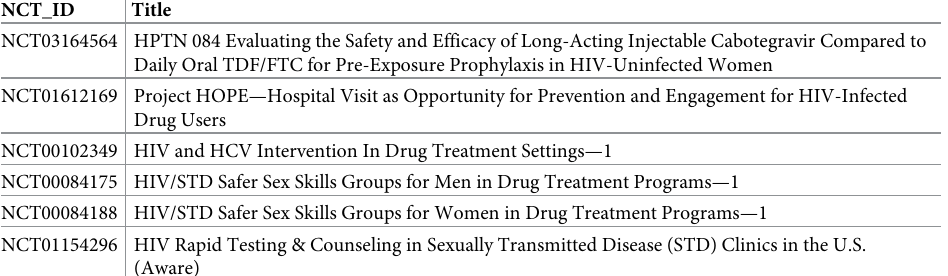
Table 7. List of acquired studies using